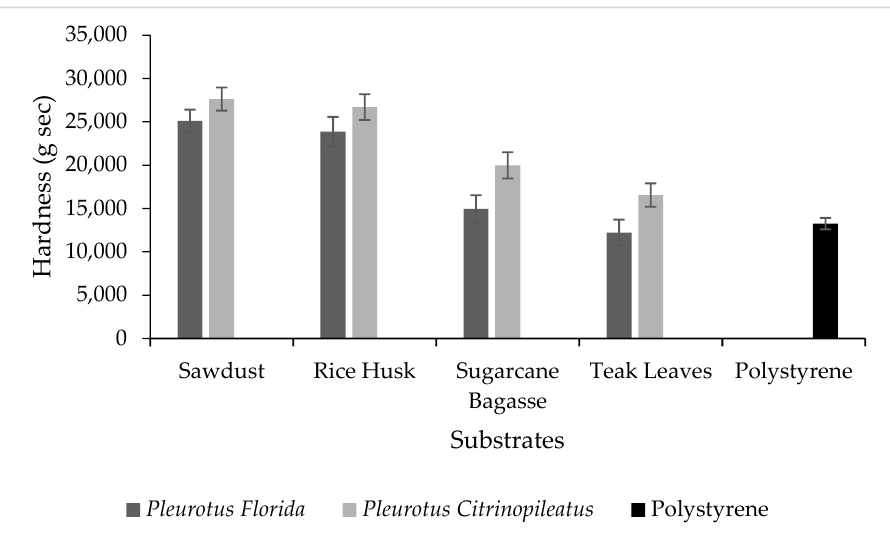
Figure 2. Hardness for different mushroom species of fungal foam in various types of substrates and polystyrene as the control.